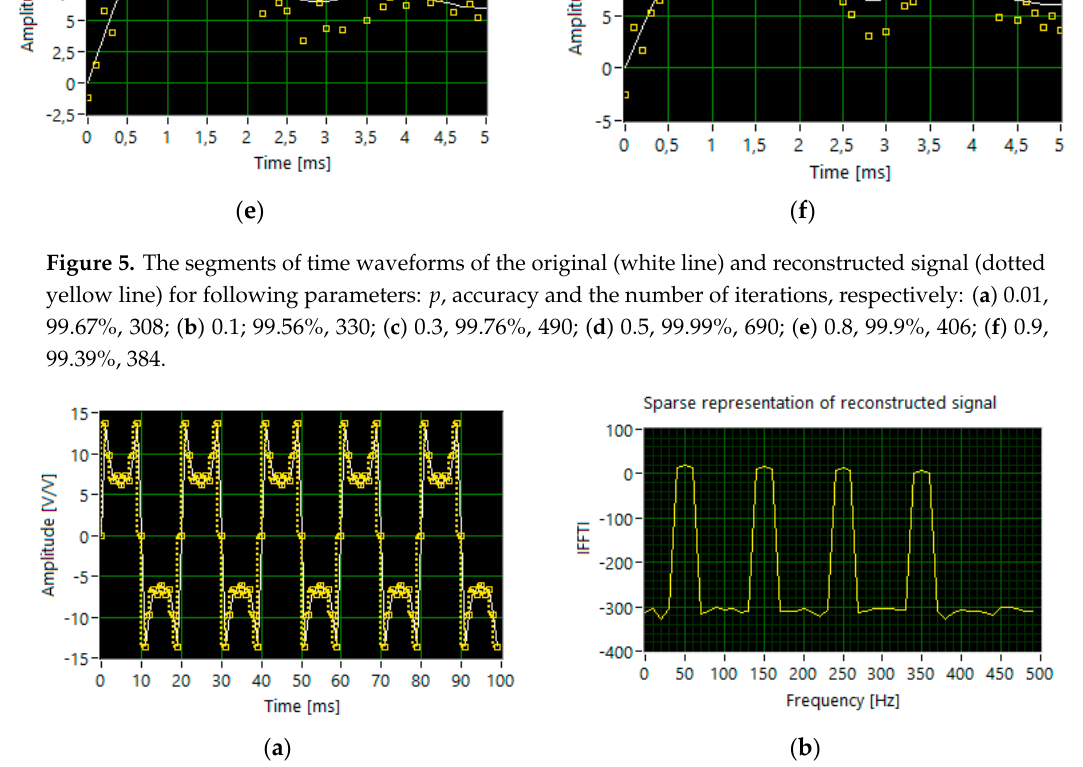
Figure 6. The results of simulation for set 1: ( a ) the segments of time waveforms of the original (white line) and reconstructed signal (dotted yellow line); ( b ) DFT components of the reconstructed signal.